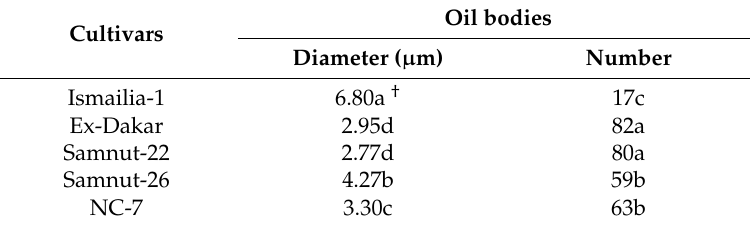
Table 8. Mean diameter and number of oil bodies in seed cells of di ff erent peanut